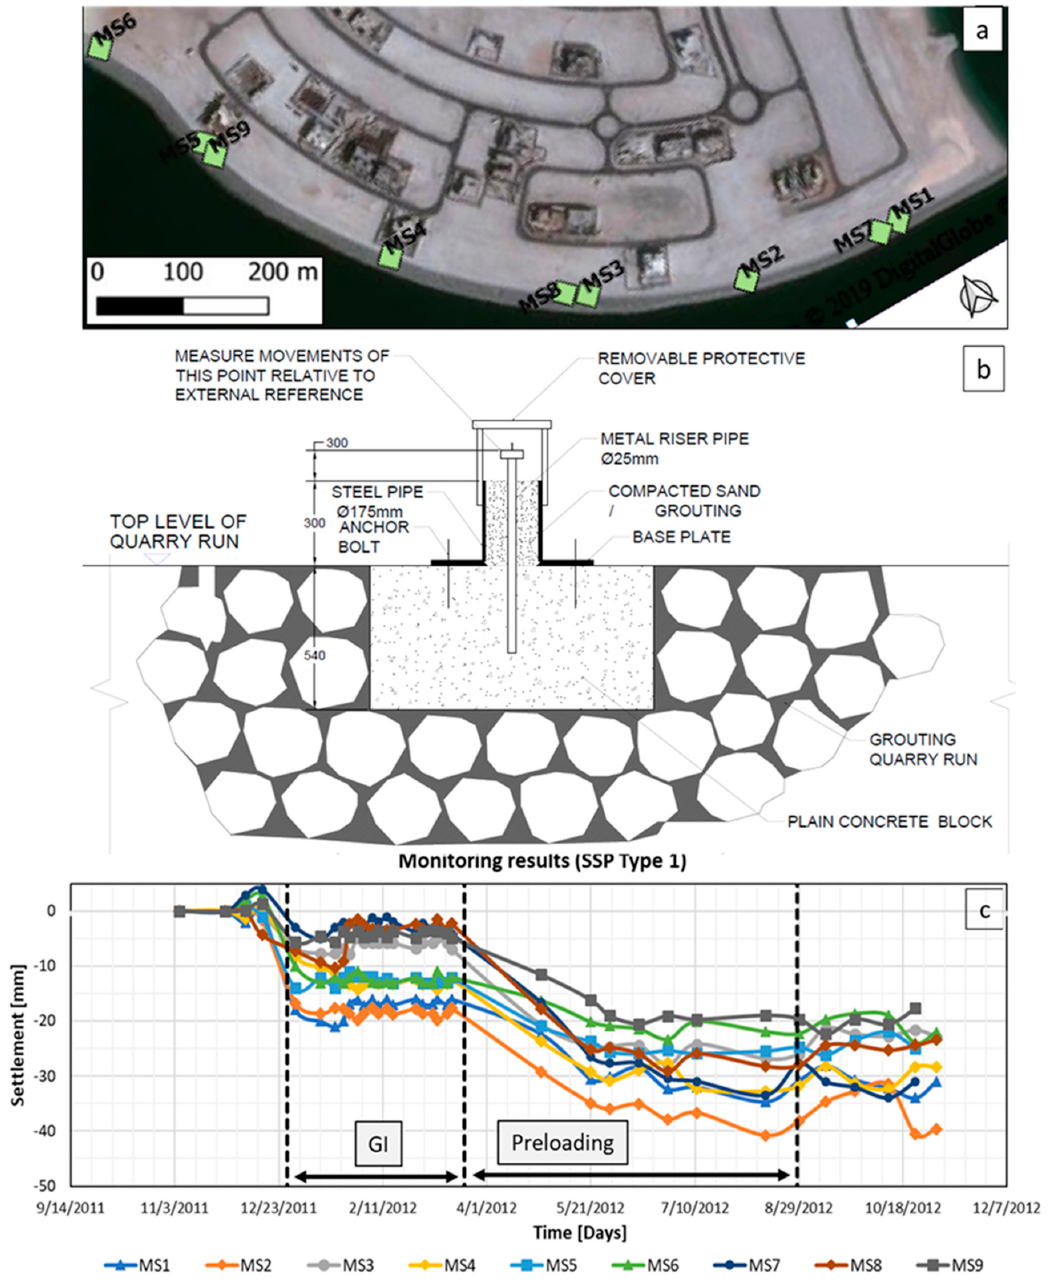
Figure 8. Plan view ( a ), typical details ( b ), and results ( c ) of the existing settlement monitoring (survey) points. Dimension in ( b ) is in millimeters. GI stands for ground improvement. The settlement points are located on top of the revetment during the preloading stage over one